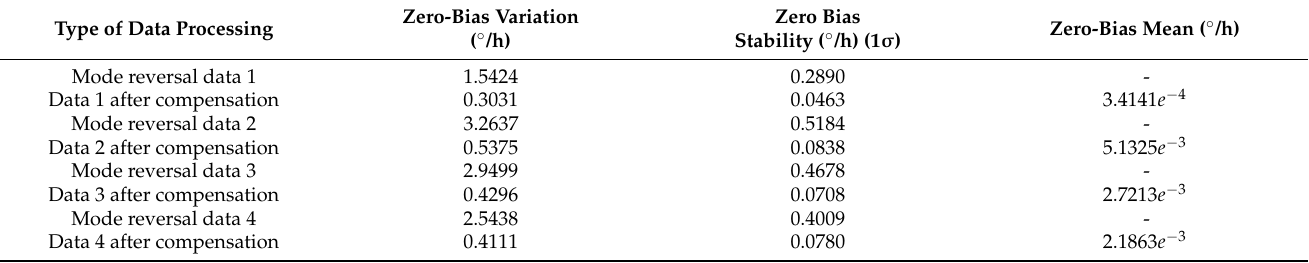
Figure 10. Comparison of zero-bias drift compensation results in the rapid heating-up stage of the gyroscope in mode reversal. ( a ) Before compensation. ( b ) After compensation. Table 4. Comparison of zero-bias drift compensation effects in the rapid heating-up stage of the gyroscope in the fast mode reversal.